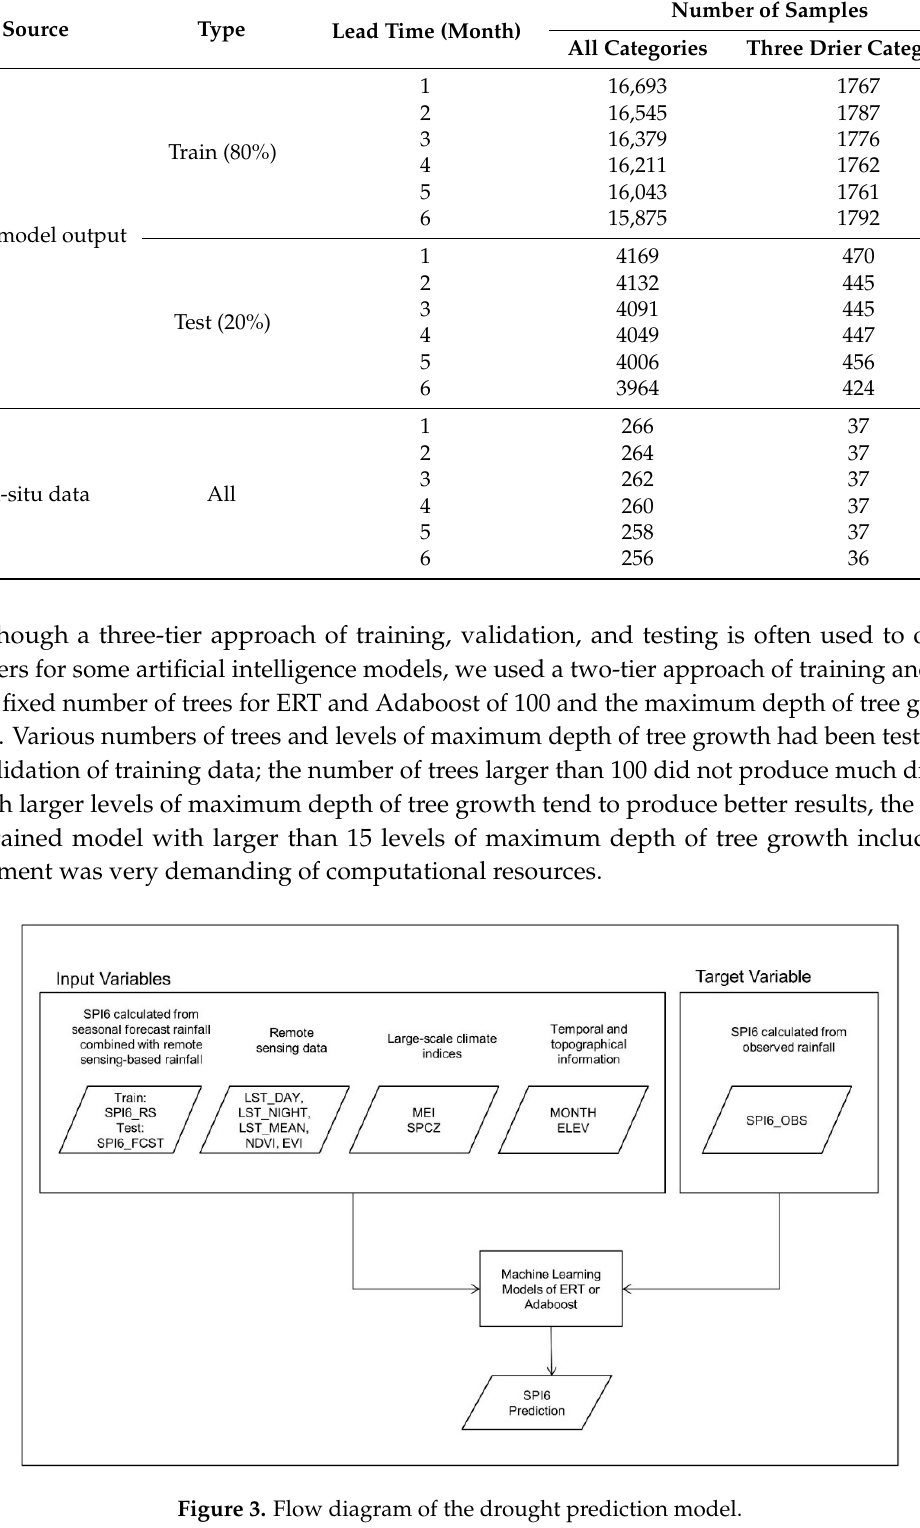
Figure 3. Flow diagram of the drought prediction model.